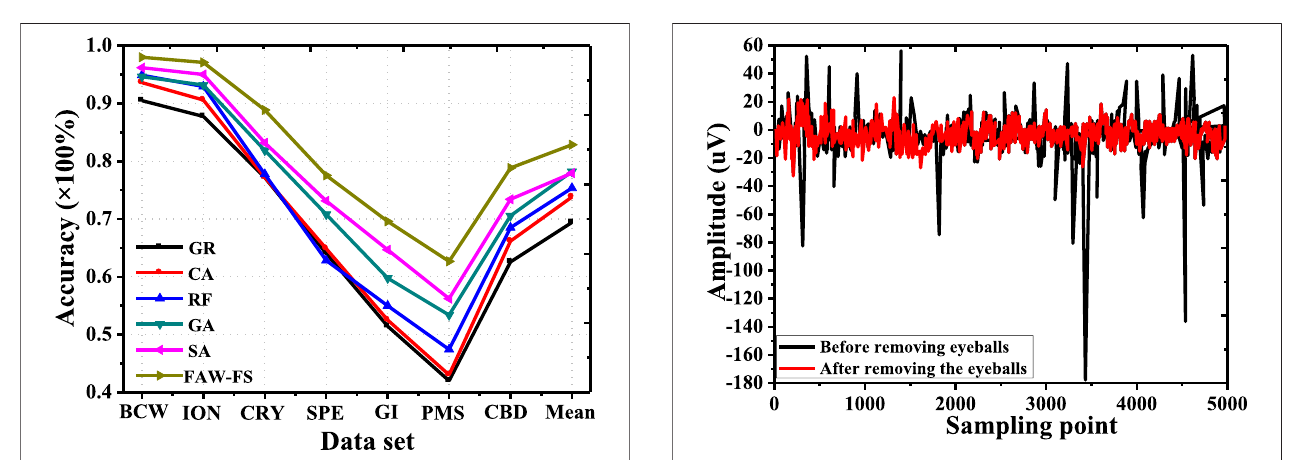
greatly than the accuracy of other algorithms, and its classi fi cation accuracy was 61.93 – 99.26%, with the mean classi fi cation accuracy of 81.45%.